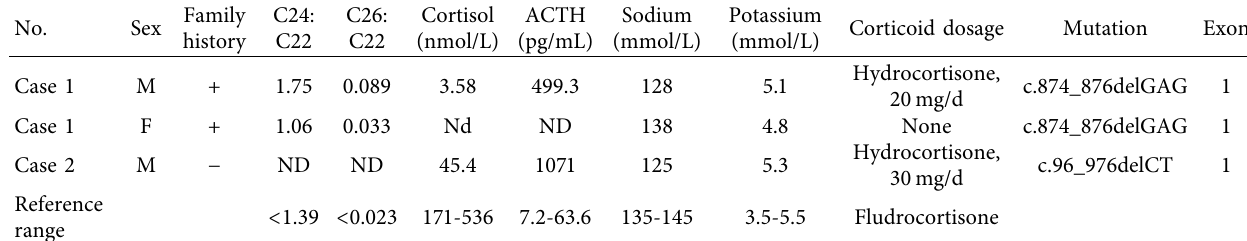
Table 1: Clinical characteristics and genetic analysis results of the